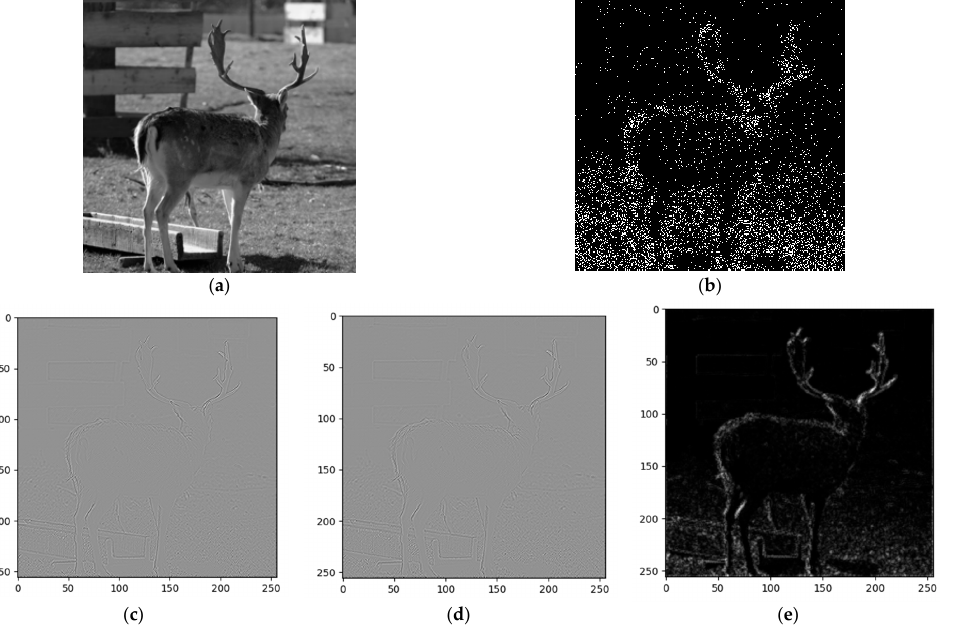
Figure 2. Output feature maps applying different fusion methods. ( a ) Grayscale image of 256 × 256 size. ( b ) Altered positions (white dots) of the grayscale image for the S-UNIWARD steganography algorithm with an embedding rate of 0.4 bpp. ( c ) Output after using the feature fusion method of weight summation for grayscale image. ( d ) Output after using the feature fusion method of taking the weight mean for grayscale image. ( e ) Output after using the feature fusion method of taking the absolute maximum value of weights for grayscale image.